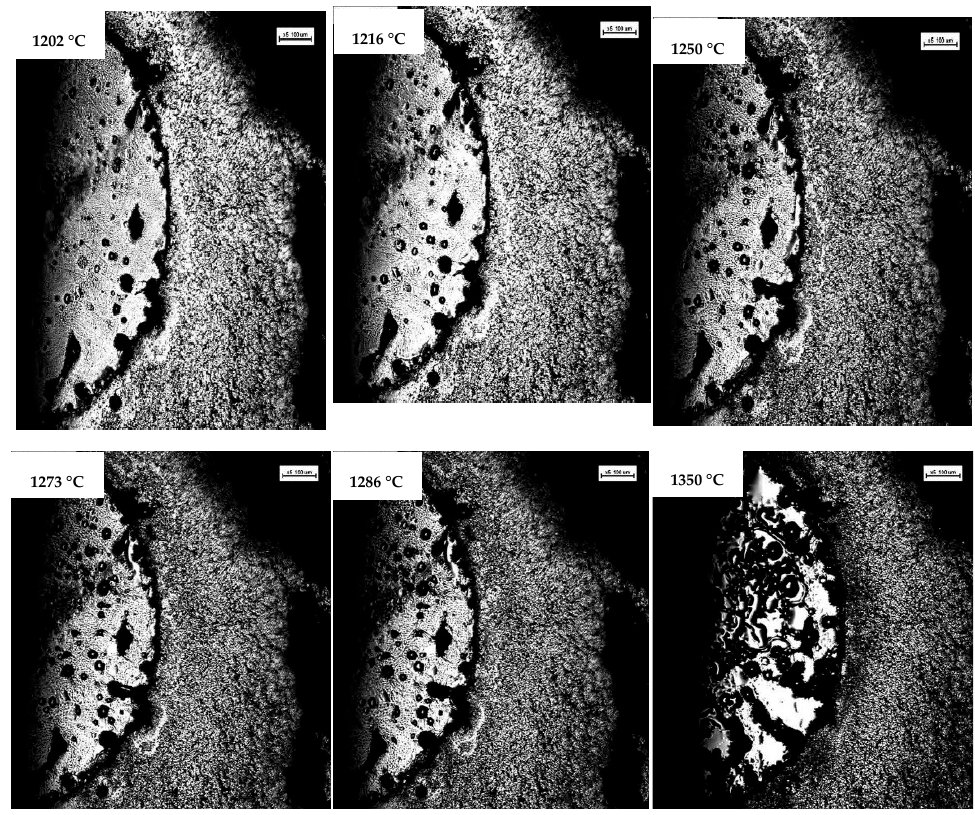
Figure 7. Composite interface changes of WC-Ni /HSS at ultra-high temperature laser confocal